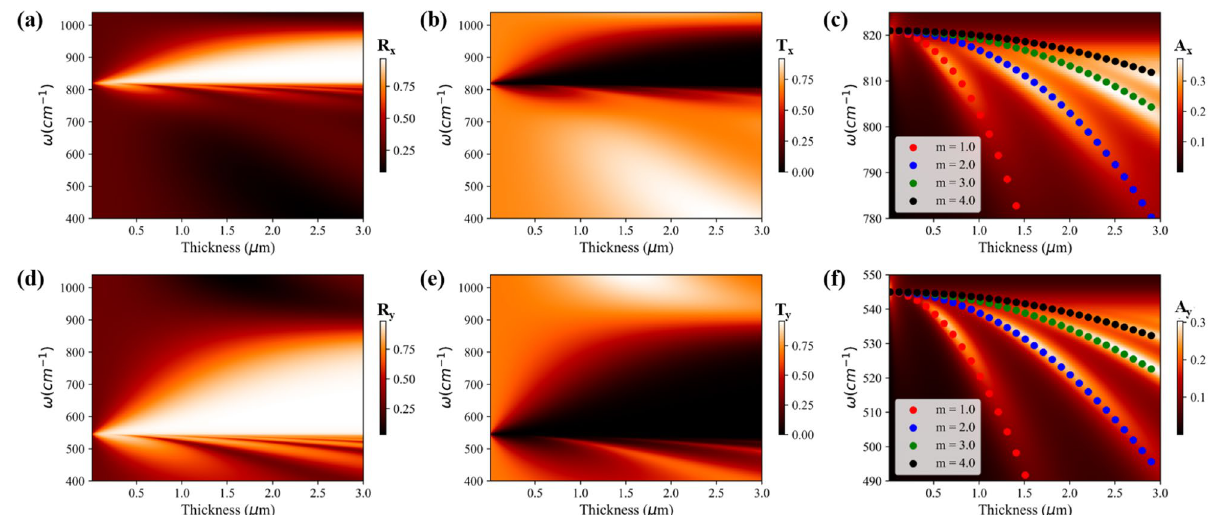
Figure 2. ( a – c ) correspond to the reflectance, transmittance, and absorbance, respectively, of α - MoO 3 for x -polarized incident light as a function of thickness and frequency. ( d – f ) represent the reflectance, transmittance, and absorbance, respectively, of α - MoO 3 for y -polarized incident light as a function of thickness and frequency. The scatter plots in absorption color plots correspond to Fabry Perot modes of α - MoO 3 film.